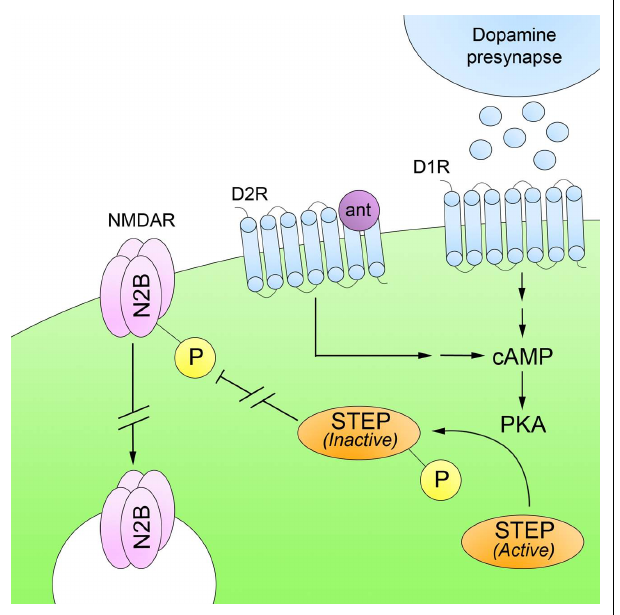
FIGURE 4 | Striatal-enriched protein tyrosine phosphatase and schizophrenia. Deficits in glutamatergic neurotransmission are believed to underlie the pathophysiology of SZ. Administration of typical and atypical antipsychotics, which are D2R antagonists (ant), increase PKA-mediated phosphorylation of STEP. Inactivation of STEP results in increased trafficking of NMDARs to synaptosomal surface membranes.This suggests that the beneficial effects of neuroleptics are mediated, at least in part, through restoration of NMDAR levels at synaptic sites.